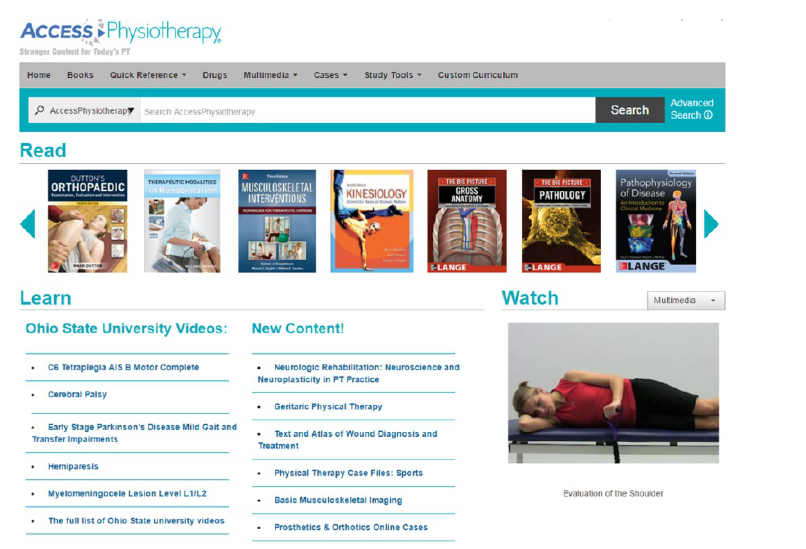
Figure 1 AccessPhysiotherapy home